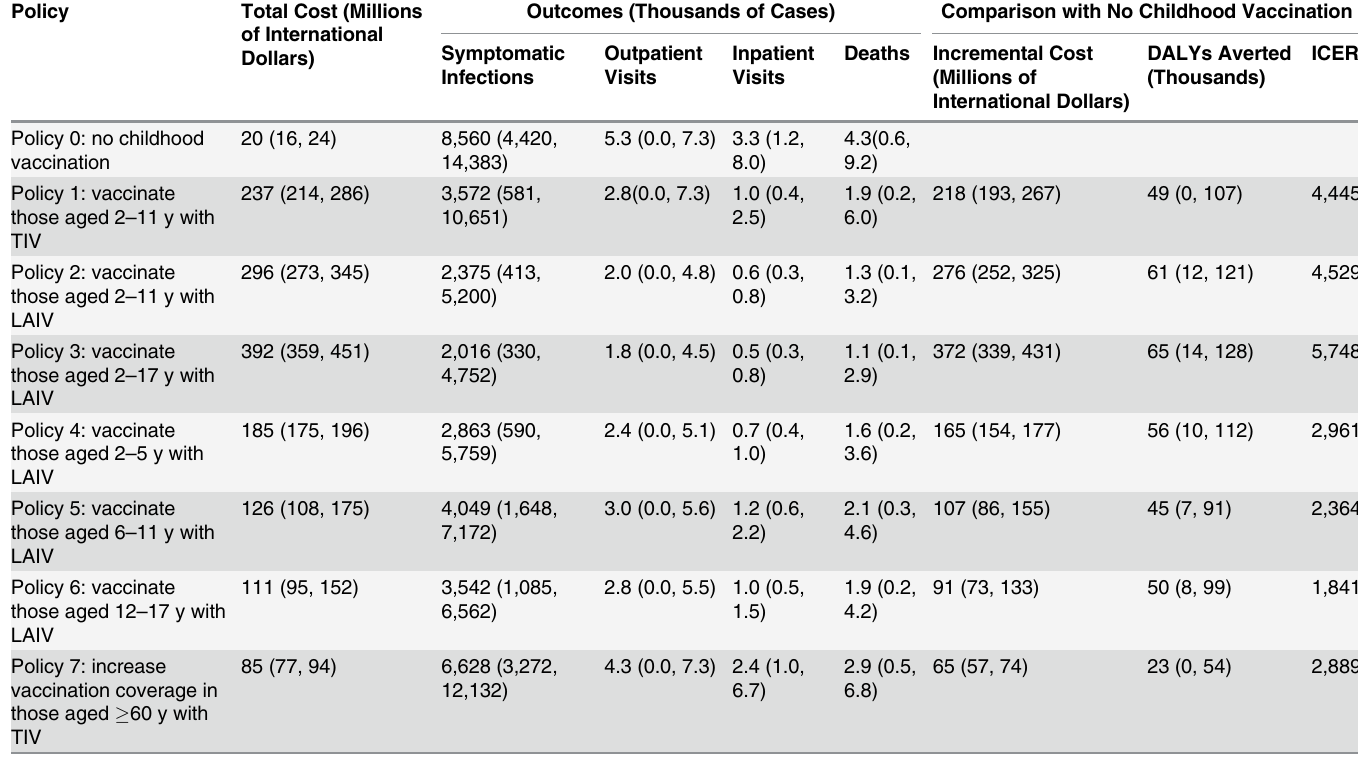
Table 5. Model outcomes showing mean (95%